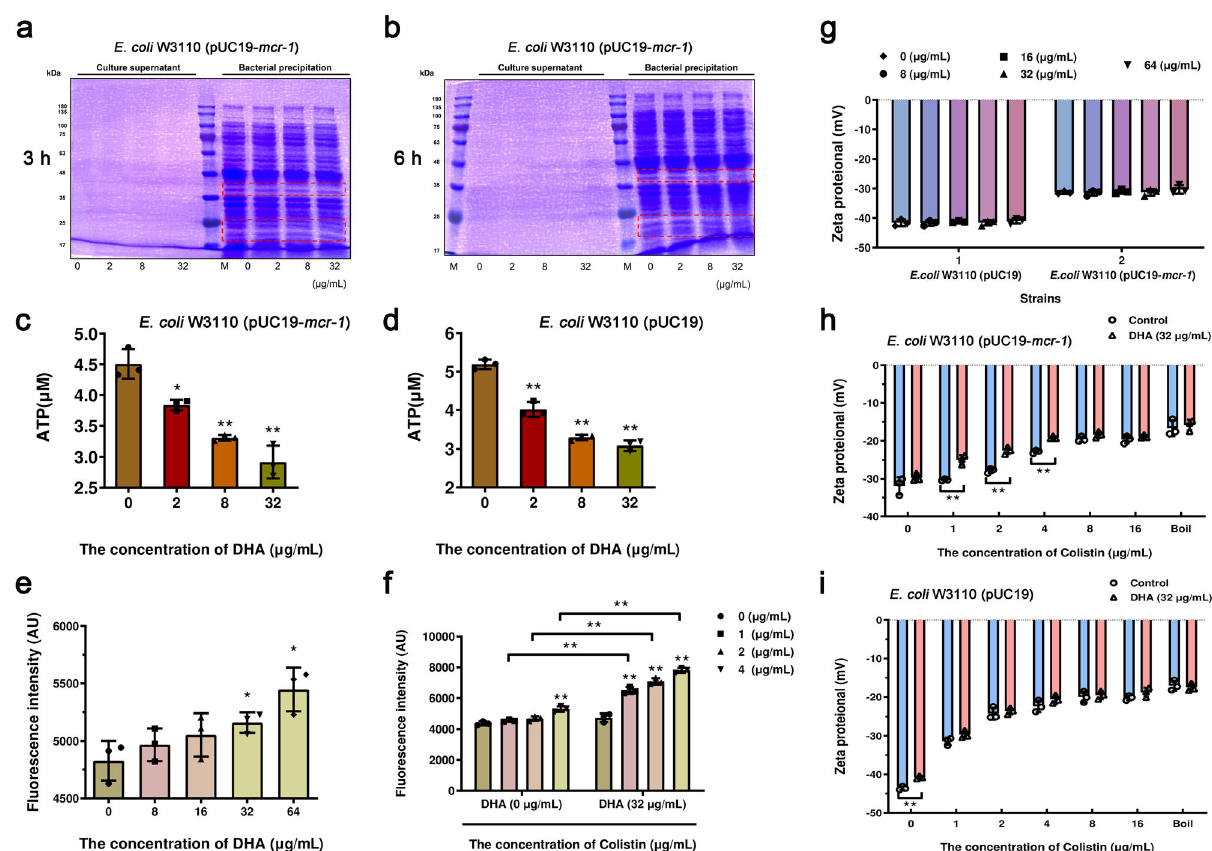
Fig. 8 DHA increases the membrane damage capacity of colistin. a , b DHA addition decreased the expression of unknown proteins (outlined in red) in the bacterial precipitation of E. coli W3110 (pUC19- mcr-1 ) at 3 and 6 h. Samples were loaded on SDS – PAGE gels and analyzed by staining with Coomassie brilliant blue. c , d Detection of intracellular ATP levels in E. coli W3110 (pUC19- mcr-1 ) and E. coli W3110 (pUC19). e , f The permeability of the inner membrane of E. coli W3110 (pUC19- mcr-1 ) treated with DHA (0, 8 – 64 μ g/mL), colistin (0, 1 – 4 μ g/mL) or colistin (0, 1 – 4 μ g/mL) in combination with DHA (32 μ g/mL) for 30 min, probed with 5 μ M PI. g – i Zeta potential of E. coli W3110 (pUC19- mcr-1 ) and E. coli W3110 (pUC19) treated with DHA (0, 8-64 μ g/ mL), colistin (0, 1 – 16 μ g/mL) or colistin (0, 1 – 4 μ g/mL) in combination with DHA (32 μ g/mL) were performed. The experiments were repeated three times independently. * P < 0.05. ** P <